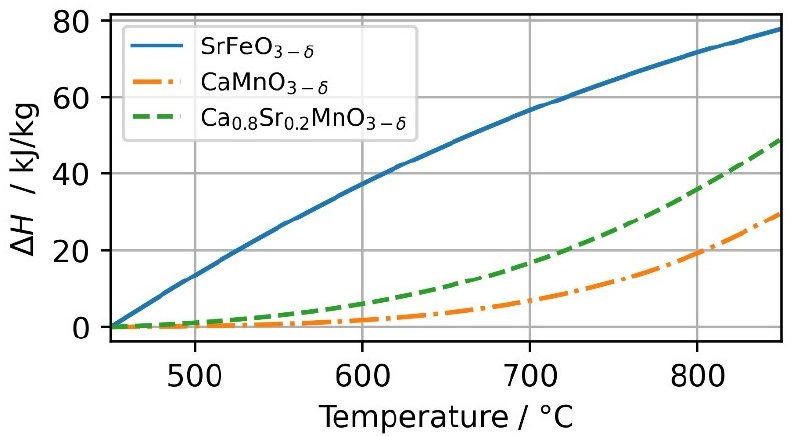
Figure 10. Reaction heat for SrFeO 3 −δ , CaMnO 3 −δ and Ca 0.8 Sr 0.2 MnO 3 −δ in the investigated temperature range of 450–850 °C at p O2 = 0.18 bar.